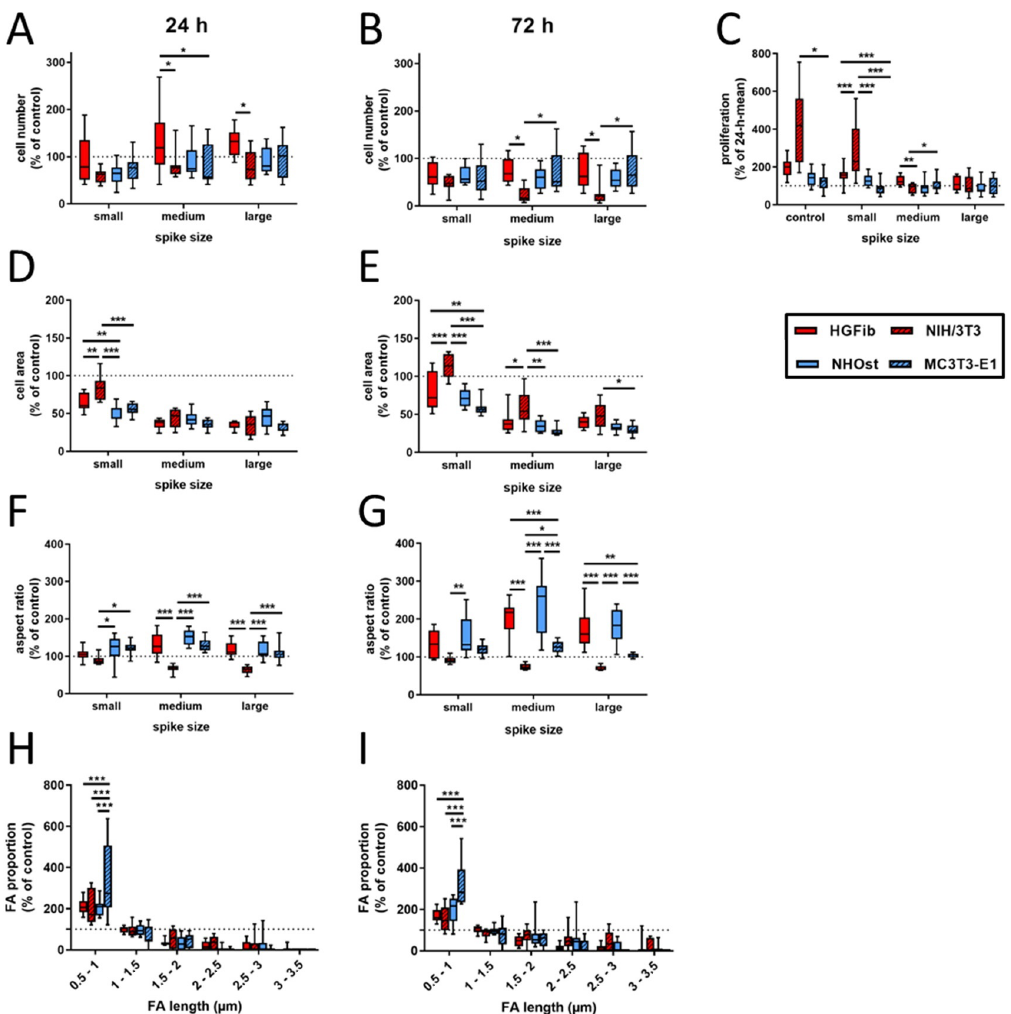
Figure 2. Cell type-specific reactions on spike topographies (direct comparison of the different cell type performances; for direct comparison of the different spike size effects, see Supplementary Figure S3). HGFib, NIH/3T3, NHOst, and MC3T3-E1 were cultivated for 24 or 72 h on the spike structures. The cell number was determined by DAPI staining ( A , B ); the cell area ( D , E ) and aspect ratio ( F , G ) were determined by phalloidin-TRITC staining. FA length was measurable only on the small spikes. The staining was done by anti-pFAK and DyLight488 ( H , I ). For calculation of cell proliferation, cell numbers after 72 h were normalized to the corresponding 24 h mean value ( C ). Data are visualized by boxplots of nine replicates of at least three independent experiments. Statistics were performed by two-way-ANOVA (* p < 0.05, ** p < 0.01, *** p < 0.001).